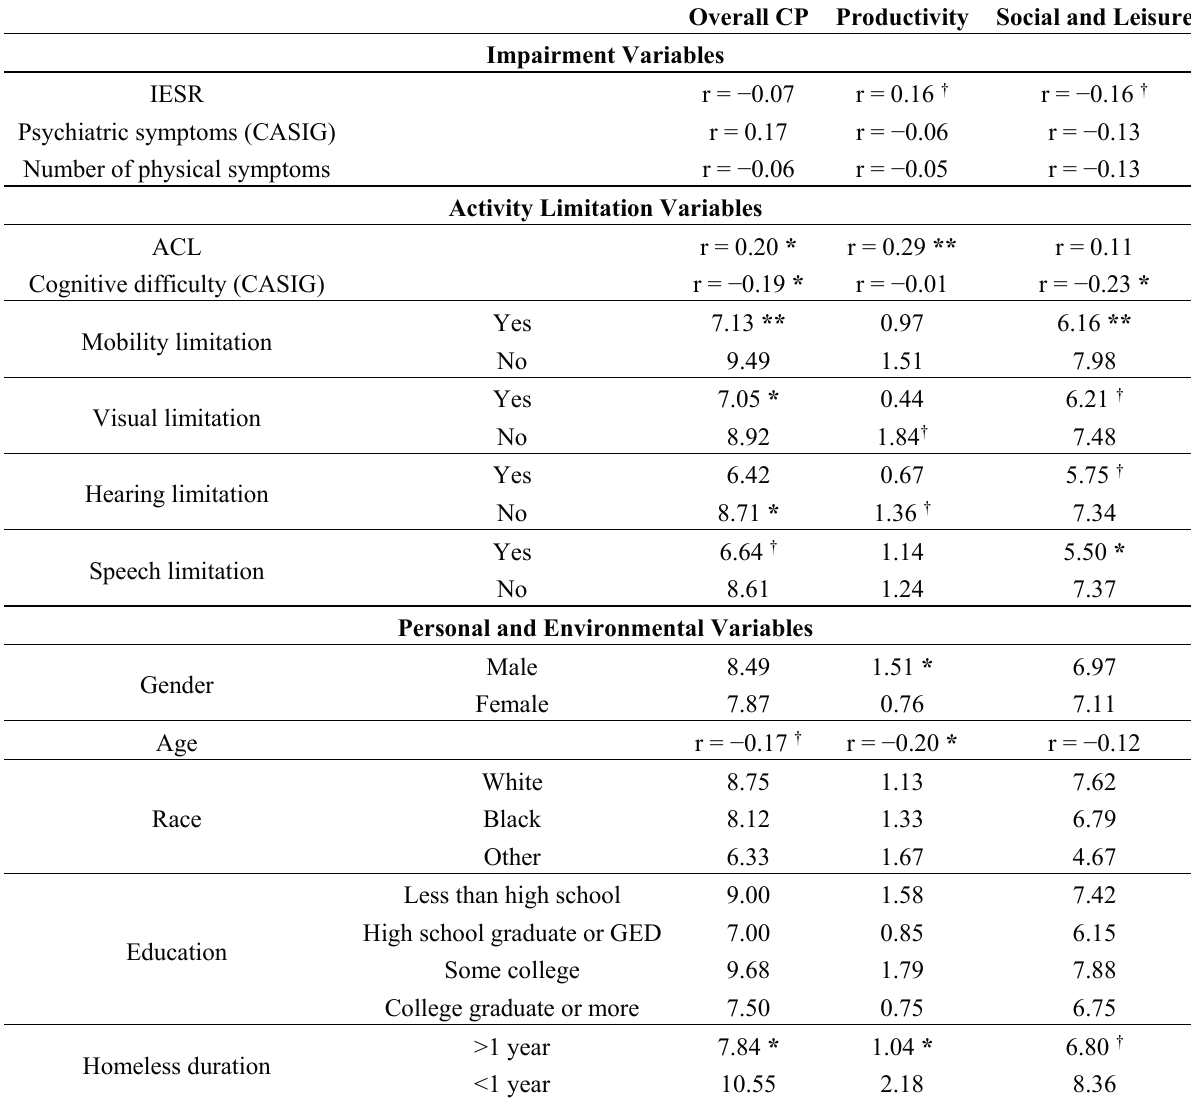
Table 2. Bivariate analysis (one-way ANOVA/ Pearson’s correlational analysis) results of community participation (CP) and the independent variables. Overall CP Productivity Social and Leisure Impairment